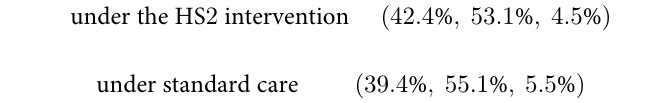
(0.375 to 0.9; baseline HS 2